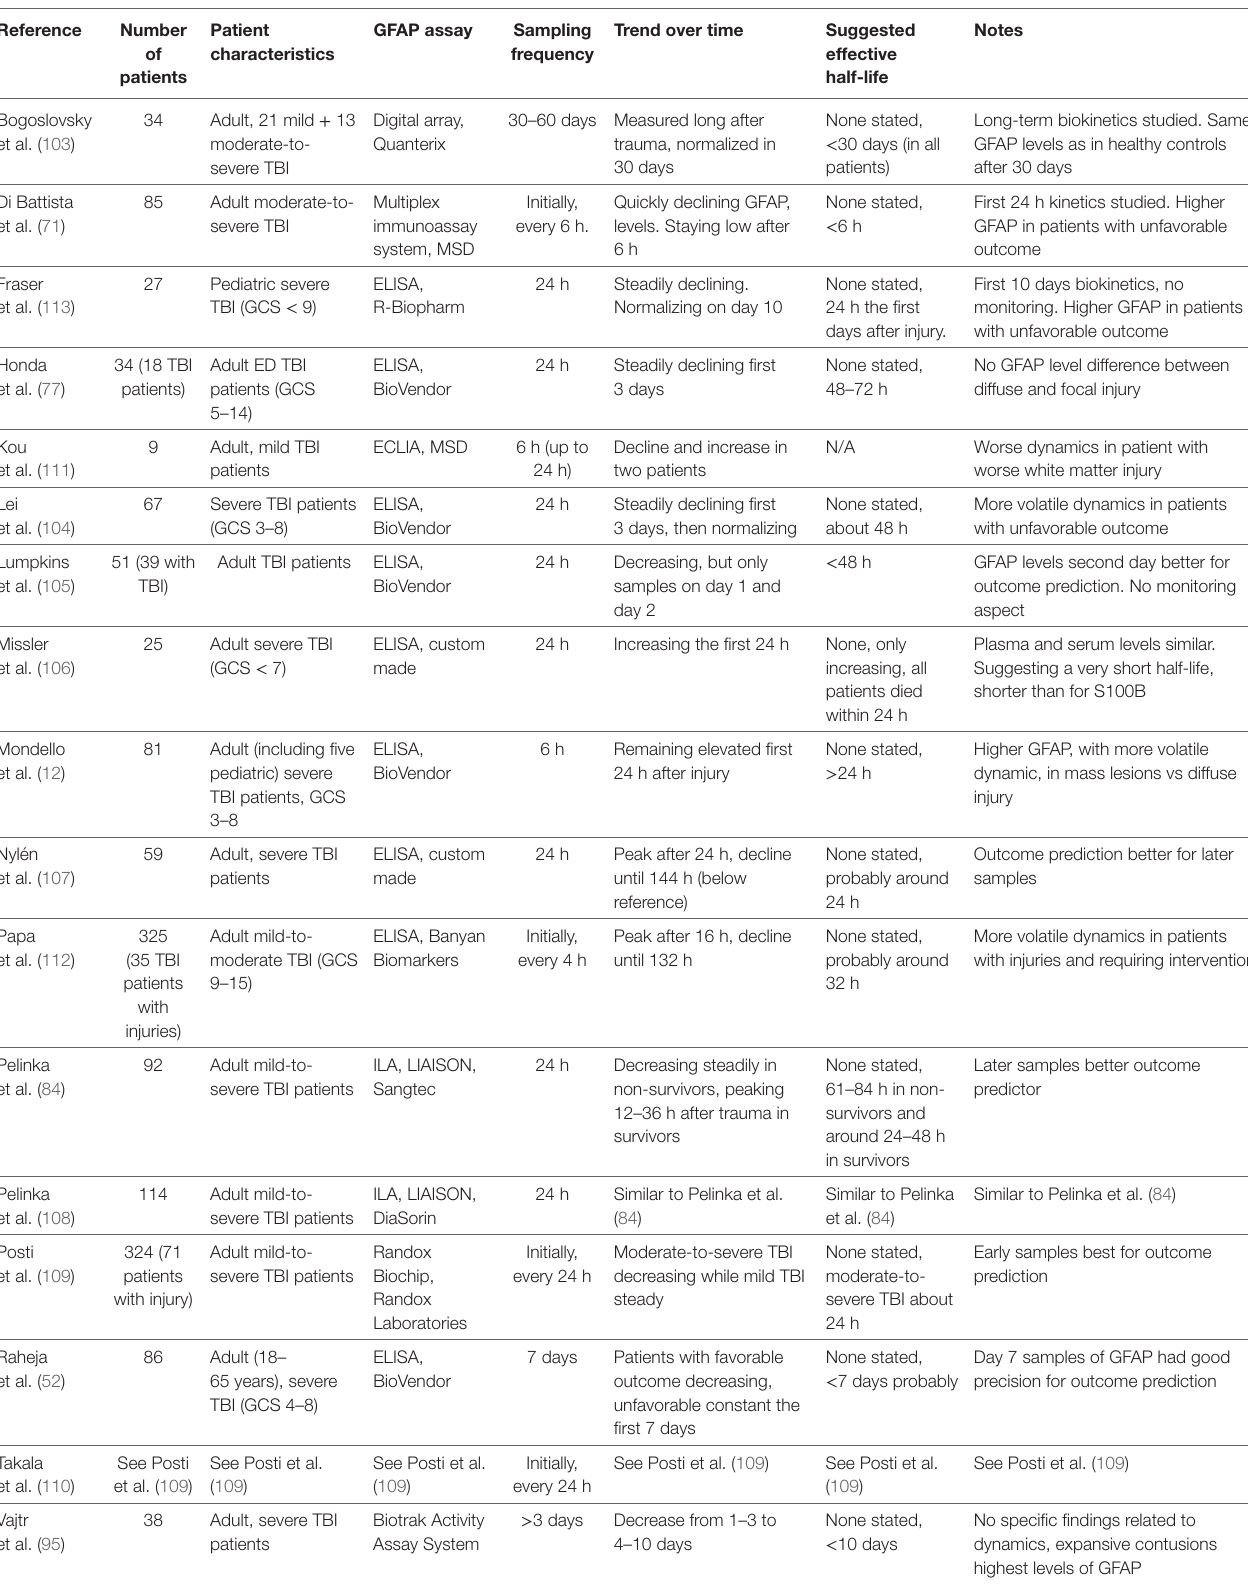
TABLe 3 | Analysis of GFAP